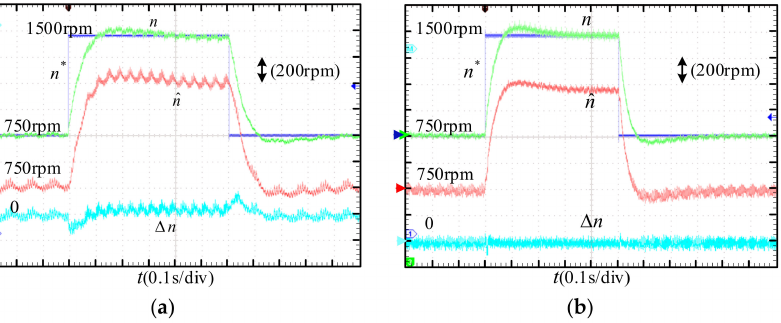
Figure 16. The experimental results under step speed. ( a ) Average speed method; ( b ) Dual ob- server method.